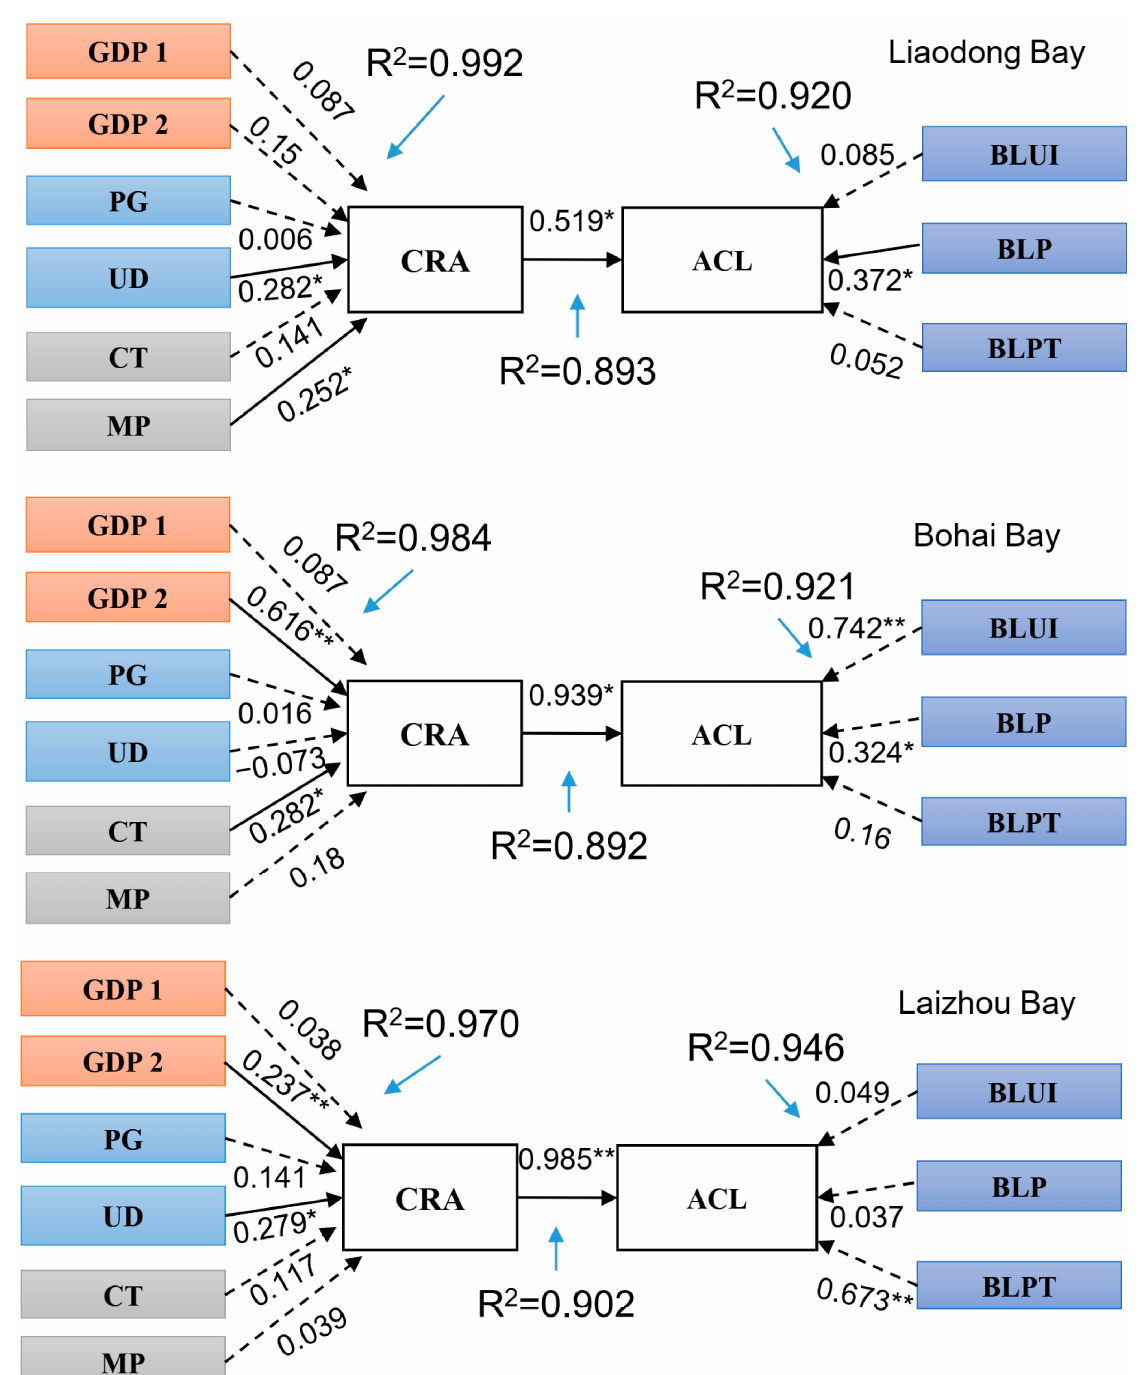
Figure 10. PC-based analysis model of driving factors of reclamation. Numbers show the standardized coefficients. Solid line indicate that the effect is significant, dotted line indicate that the effect is insignificant. The R 2 values for all the equations were high and ranged between 0.892 and 0.992, which indicate good performance. (Note: GDP1—GDP of primary industry, GDP2—GDP of secondary industry, PG—population growth rate, UD—urbanization degree, CT—cargo throughput of major ports, MP—mariculture production, BLUI—the boundary length of urban and industrial, BLPT—the boundary length of port terminals, and BLP—the boundary length of pond). * p < 0.05, ** p < 0.01.